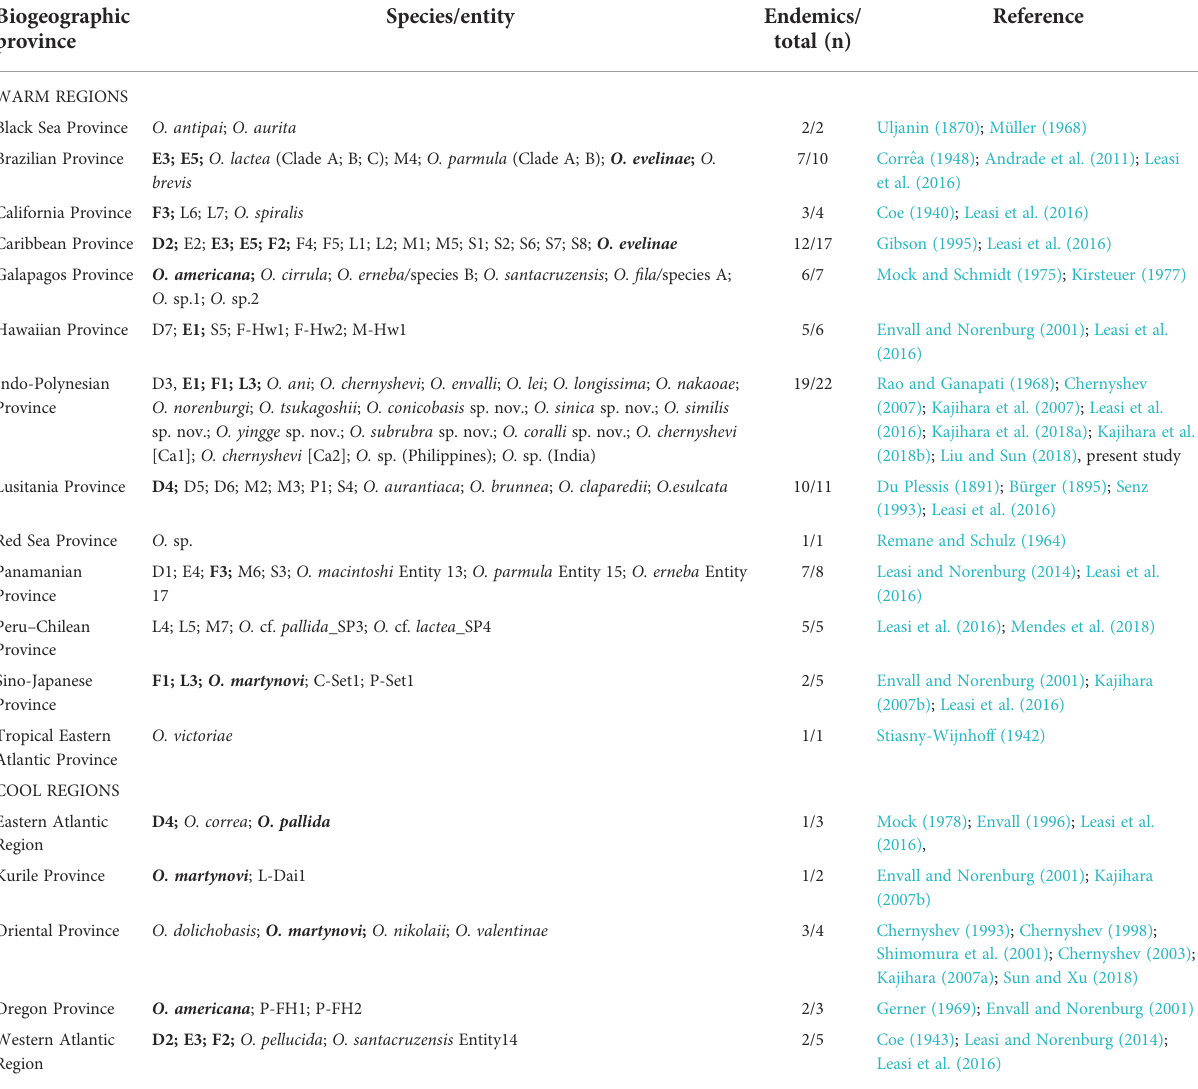
TABLE 2 Distribution of Ototyphlonemertes in marine biogeographic provinces. Species/entities occurring in two or more provinces are shown in